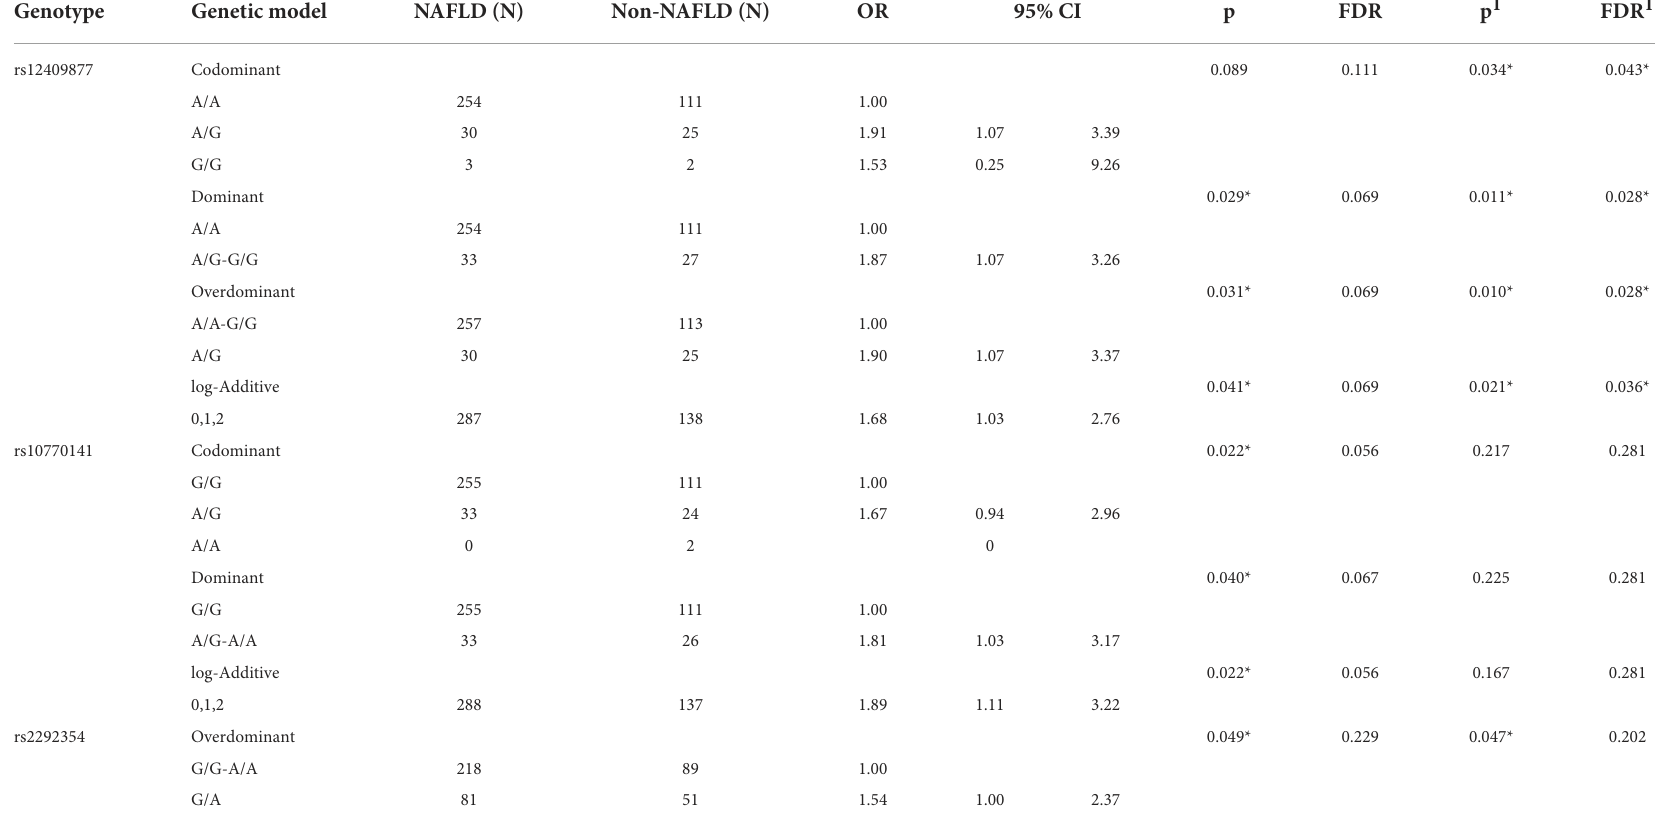
TABLE 4 Genotype distribution in five genetic models in